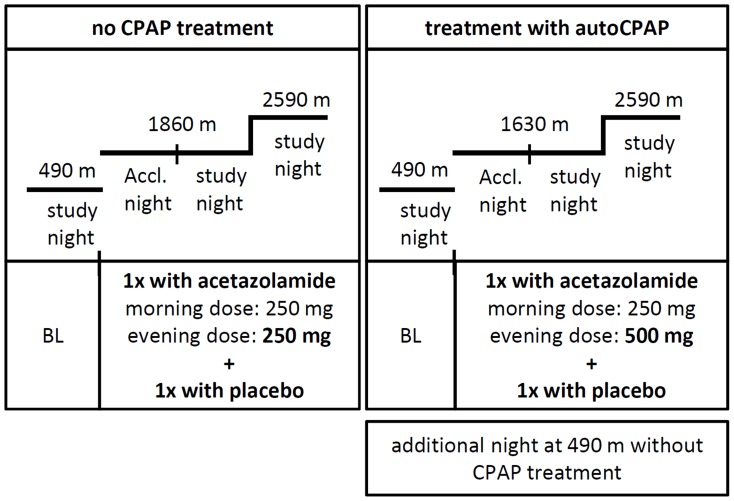
Design of the two studies (Study 1 [16]; Study 2 [3]).The n indicates the number of participants included in the present analyses. In both studies, patients underwent two 3-day sojourns at two moderate altitudes, once receiving acetazolamide and once receiving placebo with a 2 week washout period at baseline level (BL, 490 m). The first night at altitude (1860 m in study 1 and 1630 m in study 2) always served for acclimatization. The order of altitude exposure of the two study nights at lower (1860 m and 1630 m) and higher altitude (2590 m) and at baseline (BL, 490 m) were performed in a randomized cross-over design with regard to the order of altitude exposure. Patients in study 1 stopped CPAP treatment starting 3 nights before study periods at altitude and baseline. In total 5 study nights were analyzed in study 1 and 6 in study 2.